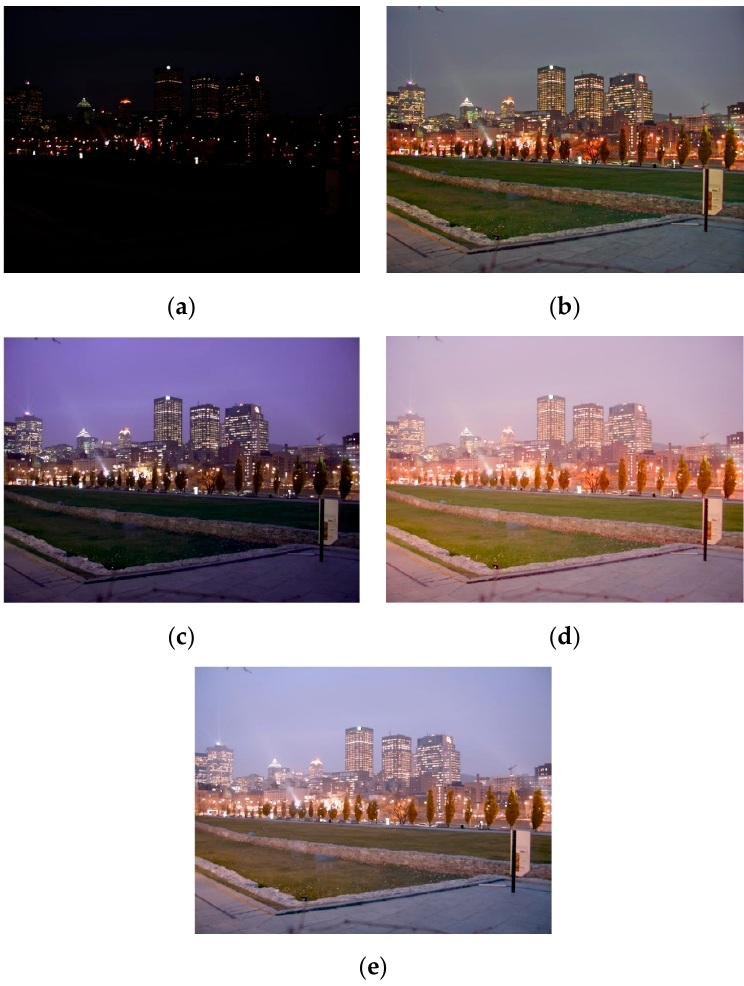
Figure 4. “Montreal_float_o935” images with ( a ) an original HDRI and resulting images of ( b ) iCAM06, ( c ) Reinhard’s method, ( d ) Choi’s method, and ( e ) the proposed method.